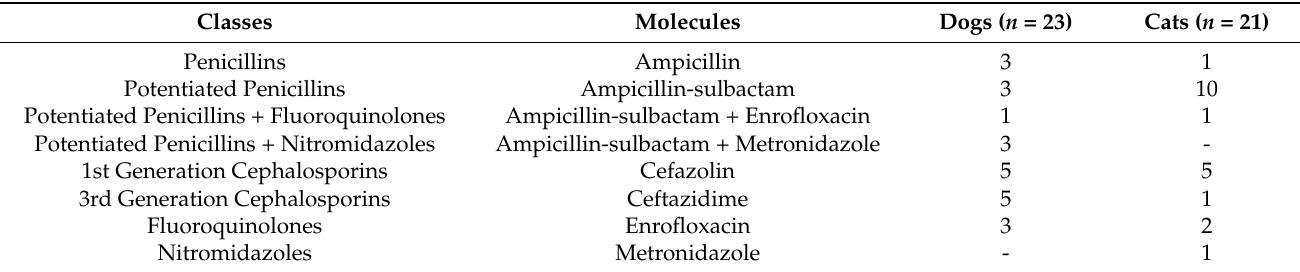
Table 3. Intravenous antibiotics administered in dogs and